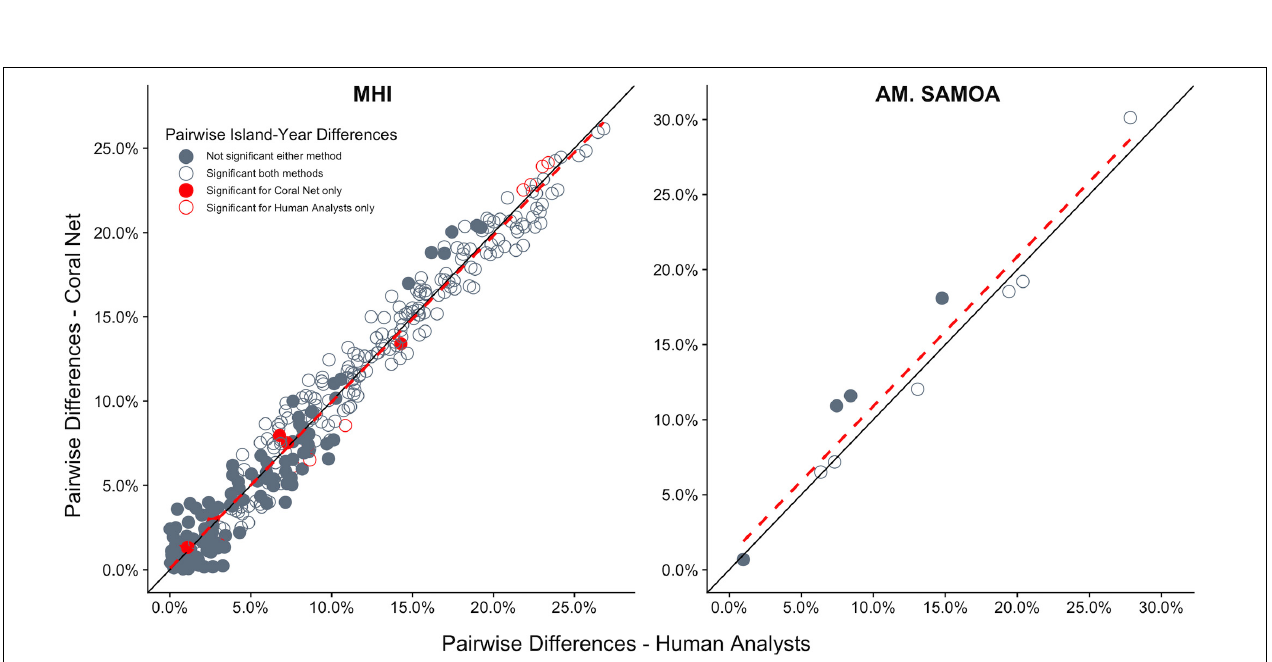
FIGURE 7 | American Samoa island-scale coral cover from human analysts and CoralNet. Coral cover mean and standard error is shown for each island. CoralNet estimates are for the “BASE” classification ( Supplementary Table S2 ). Numbers of sites per island are shown in Table 1 , but vary between 47 and 227 for American Samoa.